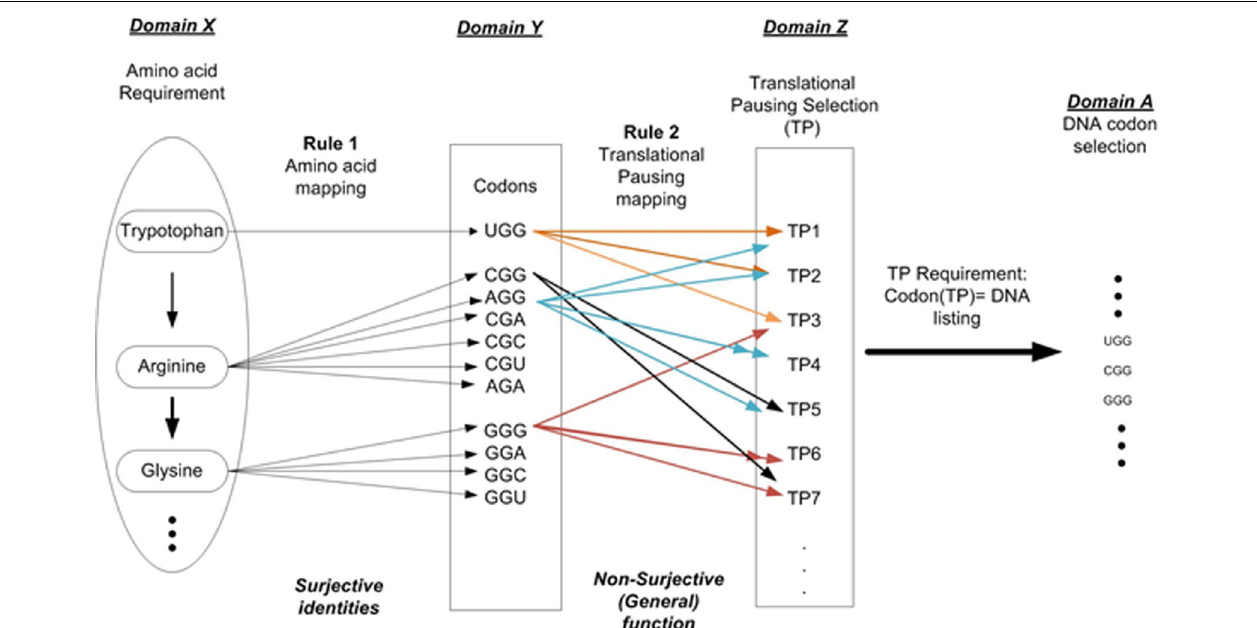
FIGURE 2 | DNA codon selection that illustrates the multi-layer requirements. Requirement 1: Amino acid selection to prescribe protein requirement. Requirement 2: Folding requirement in terms of the pausing of the translation process.